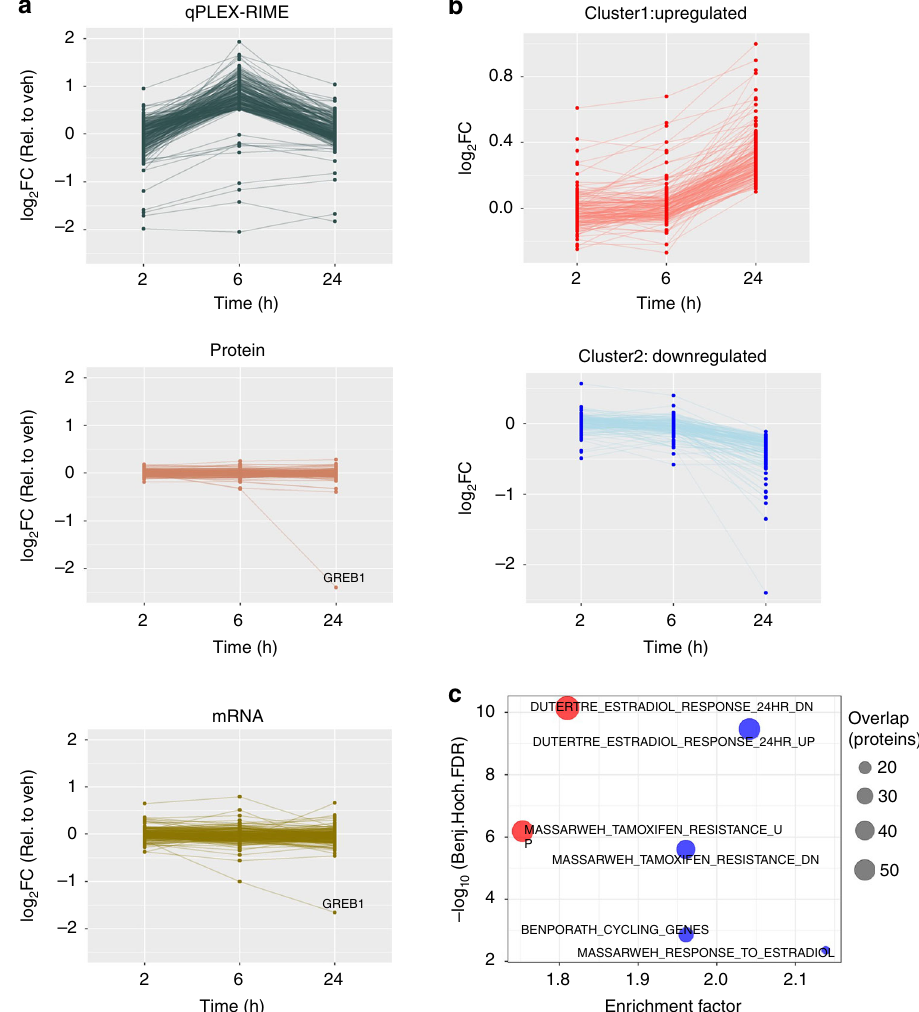
Fig. 5 Comparison of qPLEX-RIME data with total proteome analysis and RNA-seq data. a Line plots of the signi fi cantly enriched or lost proteins in the qPLEX-RIME data (top panel), their respective pro fi les in the total proteome analysis (middle panel) and in the RNA-seq analysis (bottom panel). b Line plots representing two k-means clusters of down- and upregulated proteins identi fi ed in total proteome analysis (top 10% most variable proteins with at least one signi fi cant change, adj. p -value < 0.05). c Gene set enrichment analysis for the down- and upregulated protein